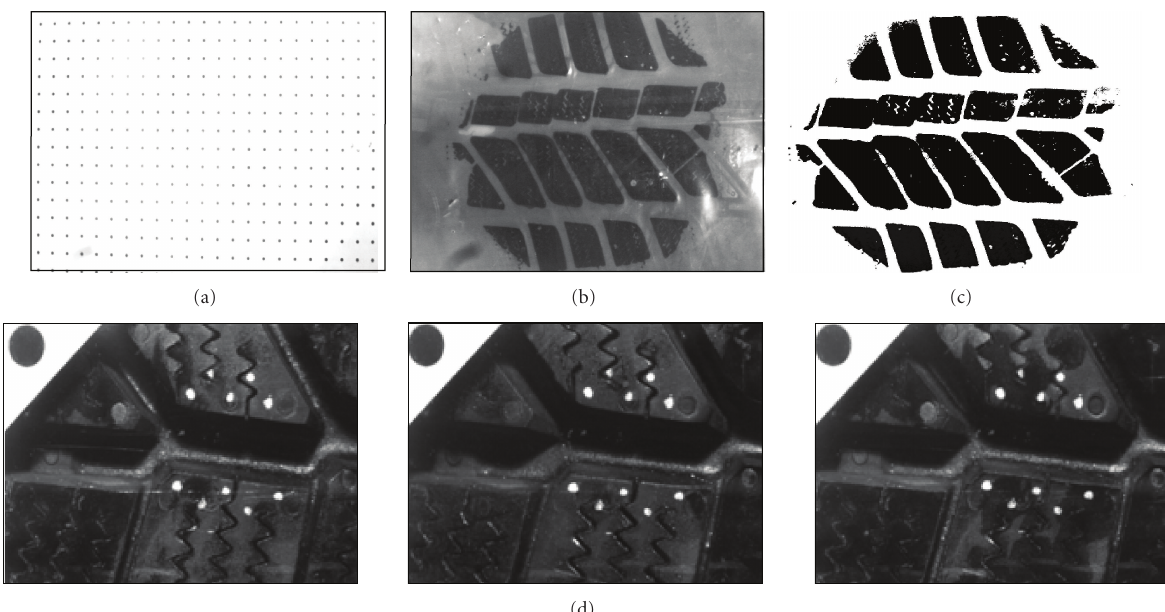
Figure 3: Examples of snapshots illustrating the test